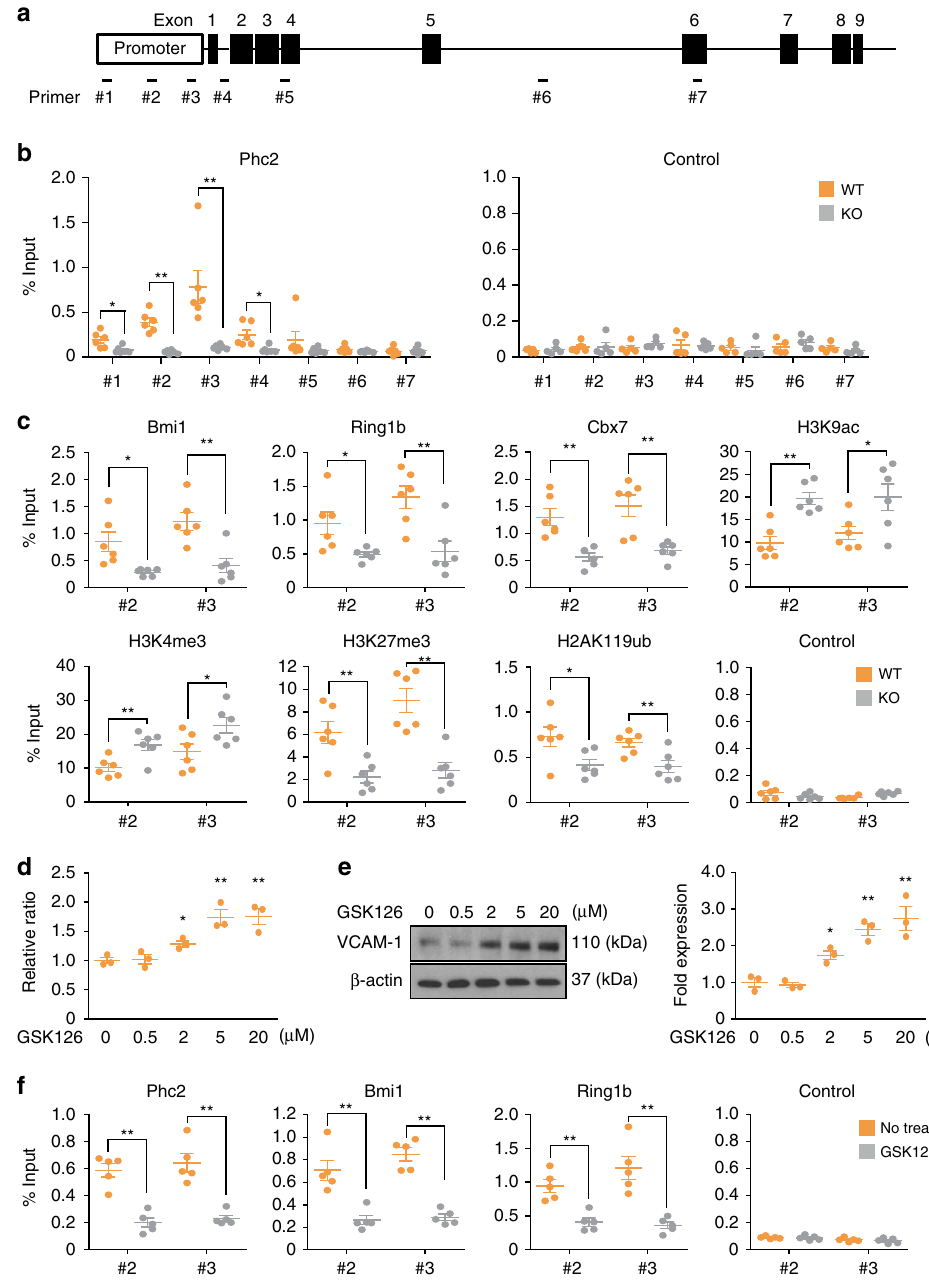
Fig. 6 Phc2 binds to the Vcam1 gene locus and suppresses Vcam1 gene expression through histone modi fi cations. a Schematic representation of the Vcam1 gene locus. The locations of primers #1 to #7 and exons are indicated. b ChIP was performed with WT and KO BM cell lysates using anti-Phc2 Ab (Phc2) or a control Ab (Control). DNA recovered from ChIP was then analyzed by qPCR. n = 5. c ChIP was performed using the same samples with indicated Abs. DNA recovered from ChIP was then analyzed by qPCR. n = 6. Control, ChIP using each isotype control Ab. d , e BMSCs (OP9 cells) were treated with various concentrations of GSK126 for 48 h. qRT-PCR ( d ) and immunoblot ( e ) analyses were then performed to measure the VCAM-1 expression levels. n = 3. f BMSCs (OP9 cells) were treated with GSK126 (5 μ M) for 48 h. ChIP was performed using cell lysates with indicated Abs. DNA recovered from ChIP was then analyzed by qPCR. n = 5. Control, ChIP using each isotype control Ab. Statistical signi fi cance was assessed by two-tailed Student ’ s t- test. * P < 0.05; ** P < 0.01. All data are presented as the mean ± SEM. Source data are provided as a Source Data